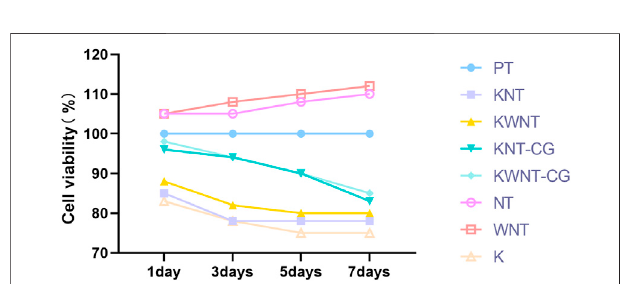
FIGURE 4 | Analysis of CCK-8